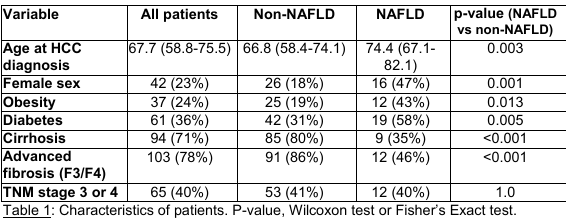
Table 1: Characteristics of patients. P-value, Wilcoxon test or Fisher’s Exact test